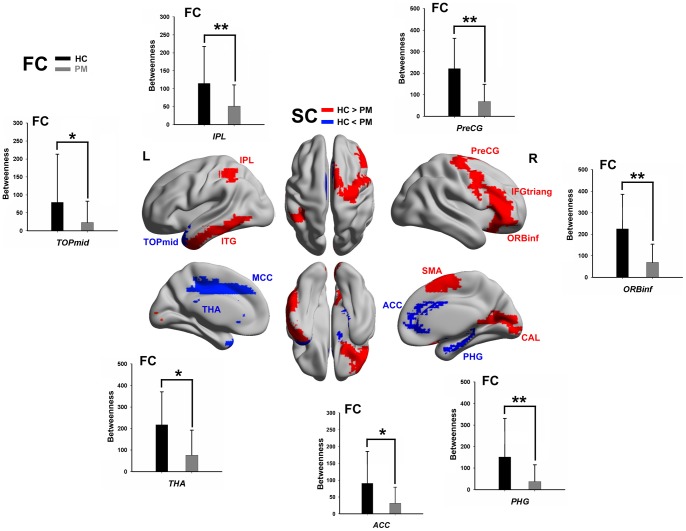
Significant between-group differences of betweenness centrality.Regions with abnormal betweenness centralities in patients' structural networks were rendered on the brain surface by visualizing it with the BrainNet viewer (red, HC>PM; blue, HC< PM). The black and grey bar graphs indicate dysregulated brain regions in patients' functional networks (nonparametric permutation test, p<0.01, corrected).